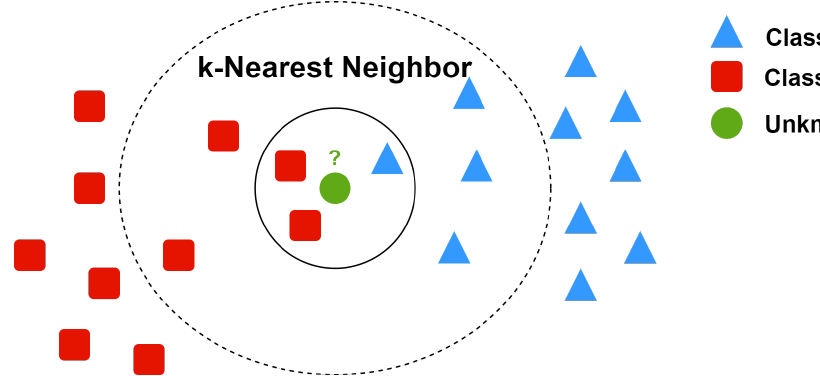
Figure 4. Working structure of a k-nearest neighbors algorithm.